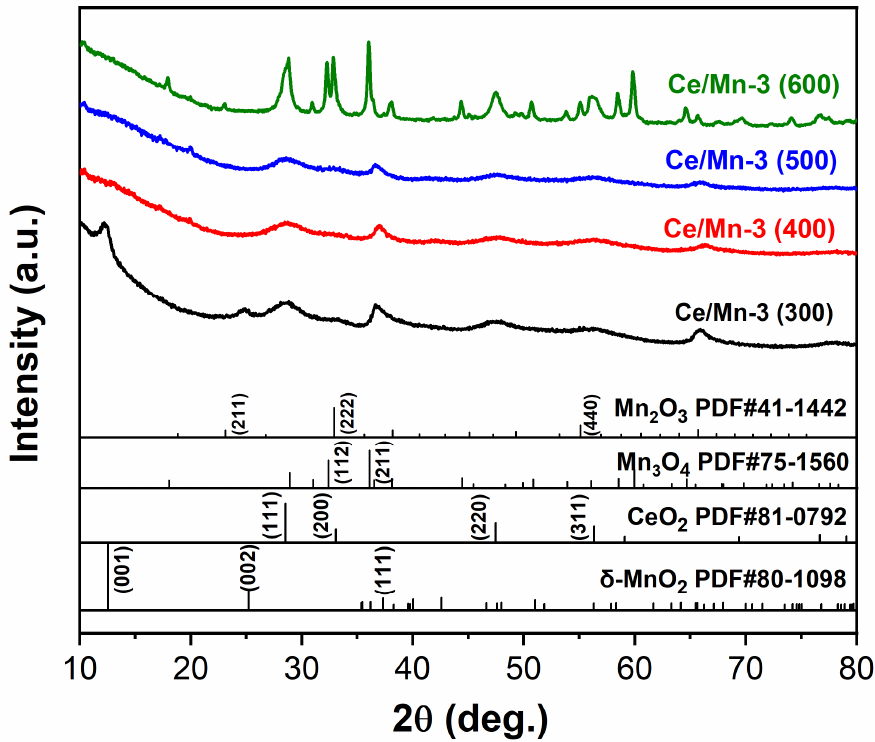
Figure 5. XRD patterns of the Ce/Mn-3 catalysts calcinated at different temperatures.